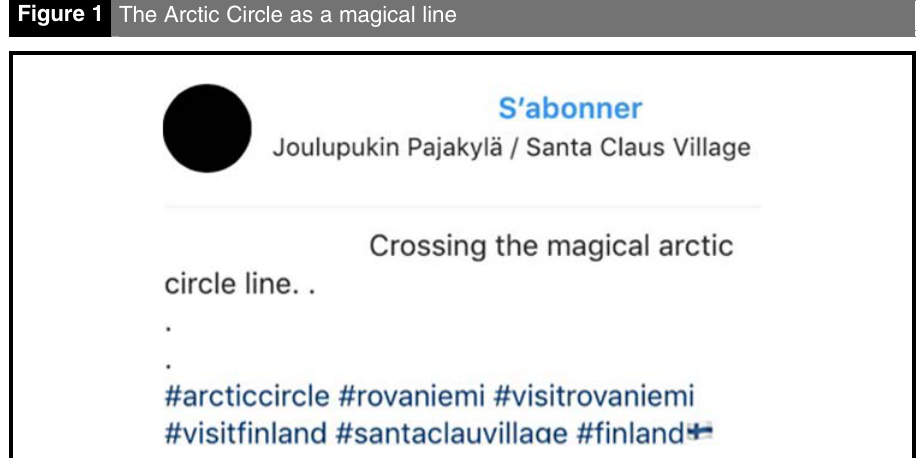
Figure 1 The Arctic Circle as a magical